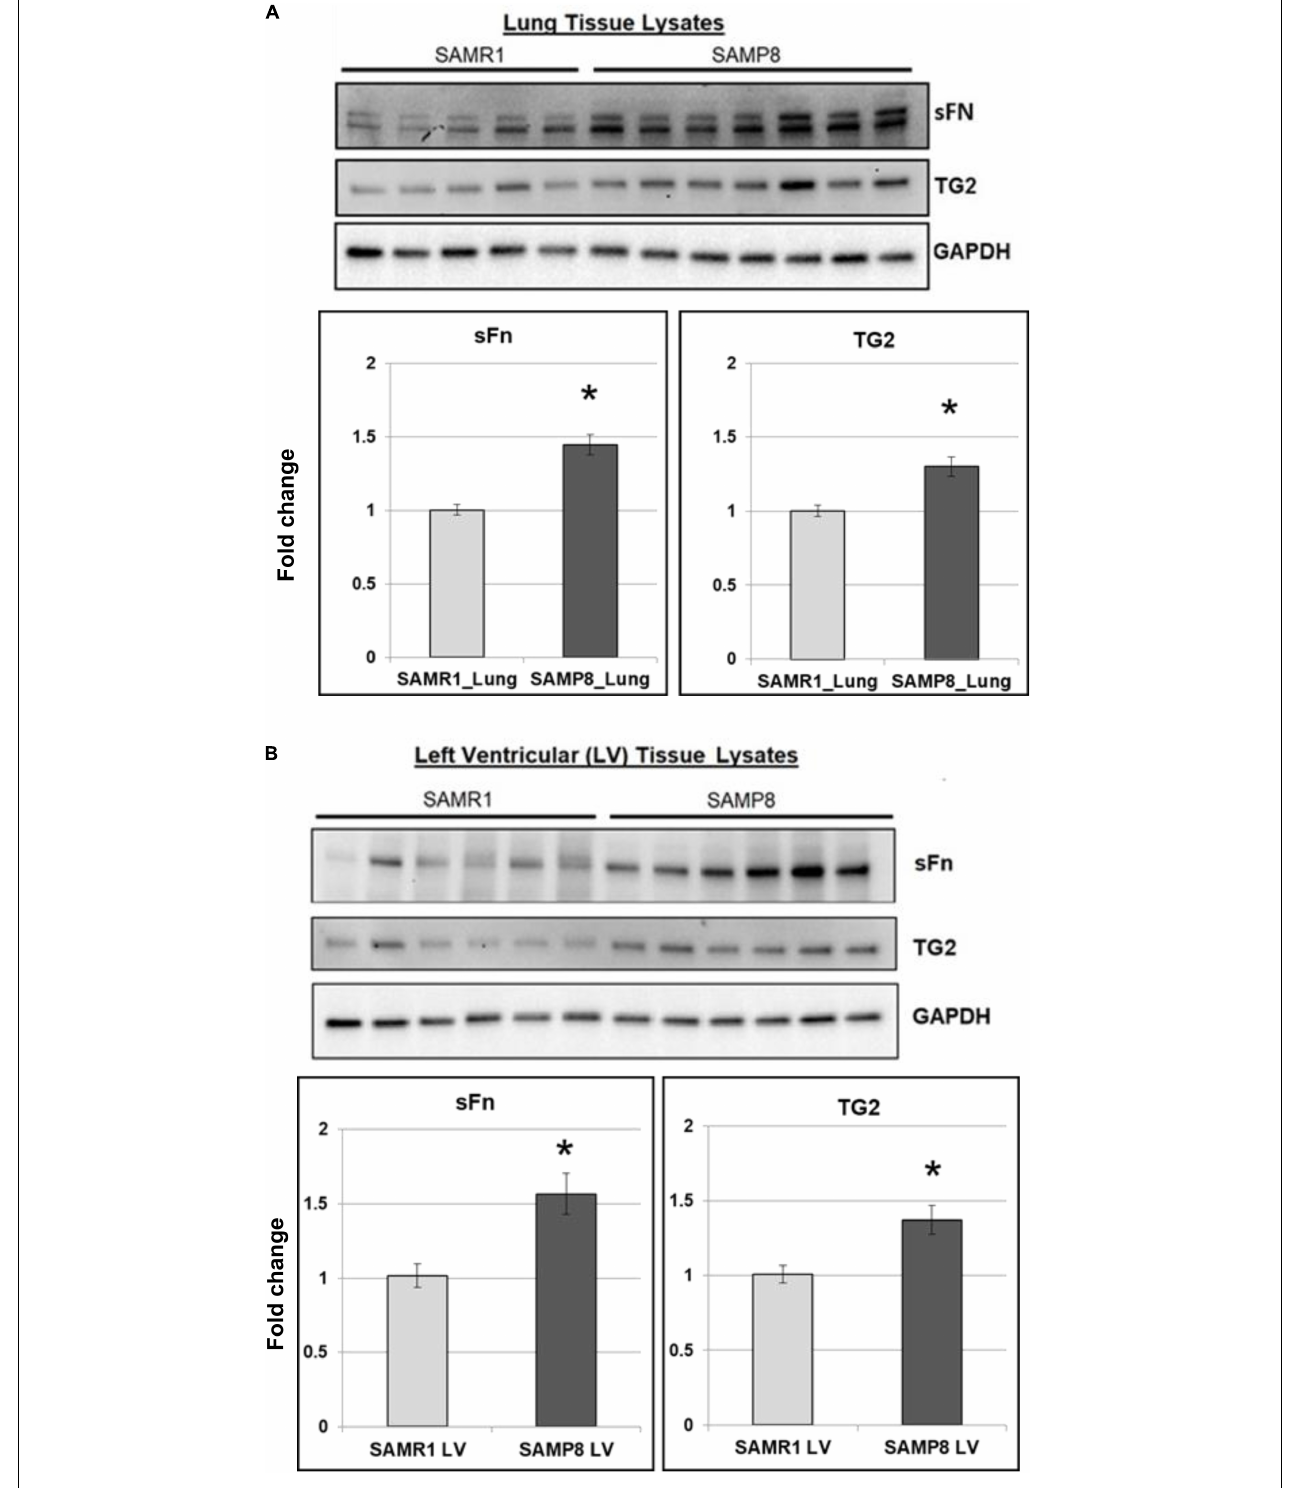
FIGURE 2 | TG2 activity and expression and fibrogenic markers are increased in mouse model of aging. Representative Western blot images showing serotonylated fibronectin (sFn) and transglutaminase 2 (TG2) expression levels in (A) lungs and (B) left ventricles of senescence-resistant (SAMR1) and senescence-accelerated (SAMP8) mice. GAPDH was used as a loading control. Bar graphs showing the normalized fold change differences compared to SAMR1 mice. Data are expressed as mean ± SEM. n ≥ 5 mice per group. * p < 0.05 compared to SAMR1 mice by t -test.